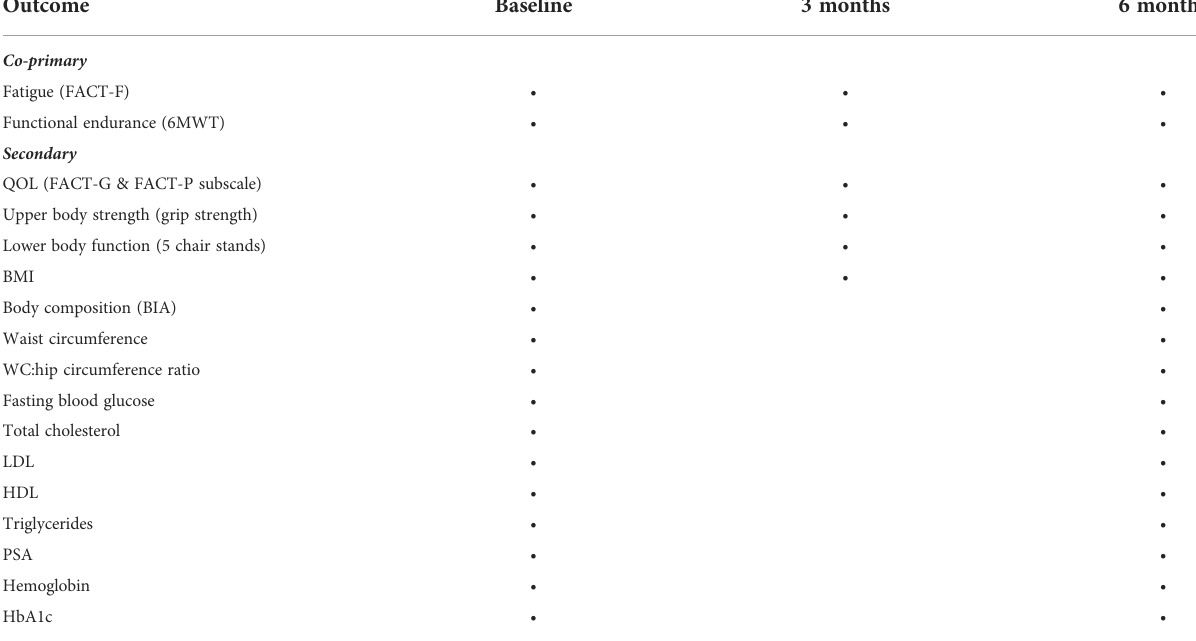
TABLE 1 Study outcomes and time points. Outcome